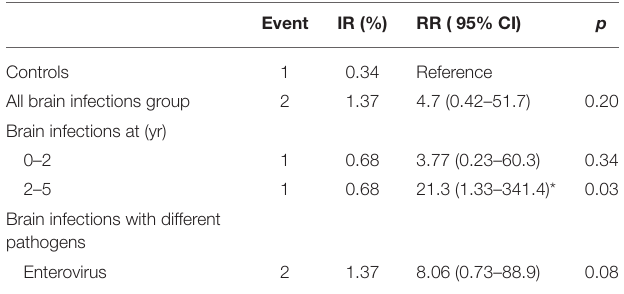
TABLE 4 | Incidence rates and relative risks of ASD for the controls compared with brain infections